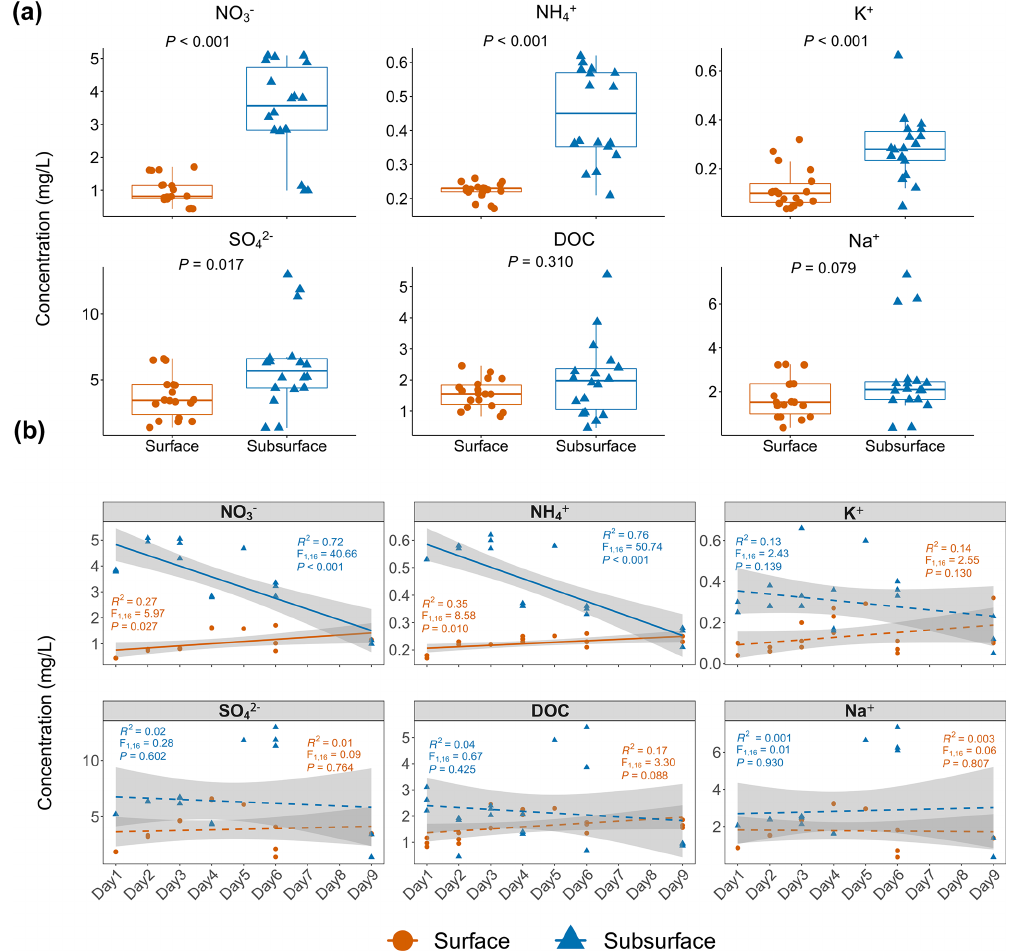
Figure 1. The pattern of environmental factor changes in the surface and subsurface snow layers. (a) Environmental factor comparisons in the surface and subsurface snow layers. Each dot represents an individual sample. Significantly higher concentrations of NO − K + , and SO 2 − were observed in the subsurface layer based on Wilcoxon rank-sum test. (b) Temporal changes in environmental factors in 4 the surface and subsurface layers. The solid and dashed lines indicate significant and non-significant temporal changes, respectively. The concentration of NO − and NH + in the surface layer significantly increased with time, while the concentration of NO − 3 4 subsurface layer, significantly decreased with time. Significance is based on linear regression. Grey shading indicates the 95% confidence interval of